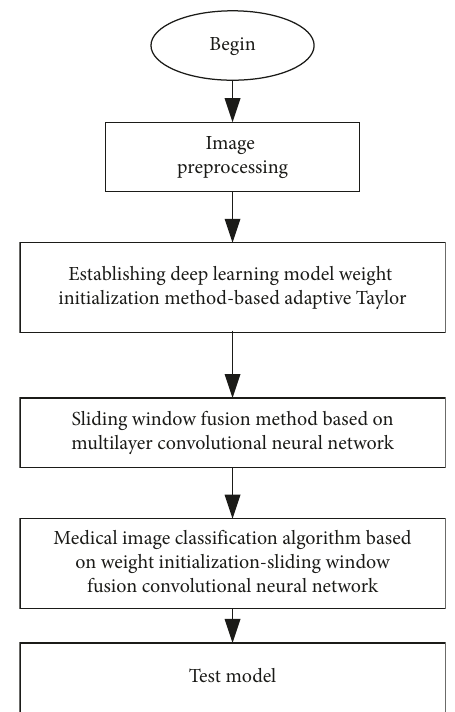
Figure 3: Basic flow chart of the medical classification algorithm proposed in this